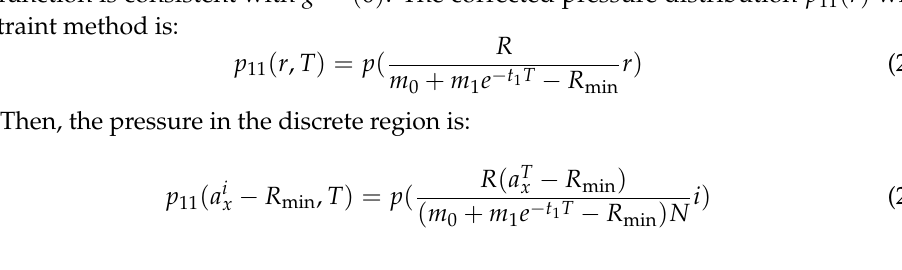
Figure 9. High-order discrete contact pressure correction curves: ( a ) ; ( b ) 554N T